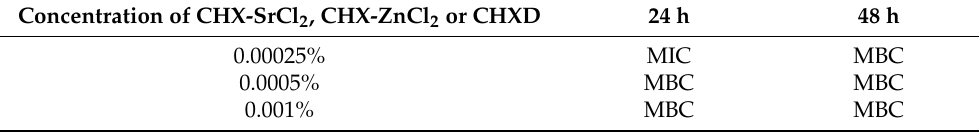
Table 1. MIC and MBC of CHX-SrCl 2 , CHX-ZnCl 2 , and CHXD against P. gingivalis and A. actino- mycetemcomitans